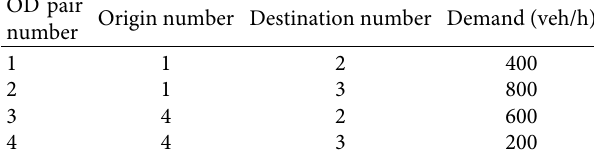
Figure 1: Test road network. Table 2: Initial travel demand of OD pair. OD pair Origin number Destination number Demand number